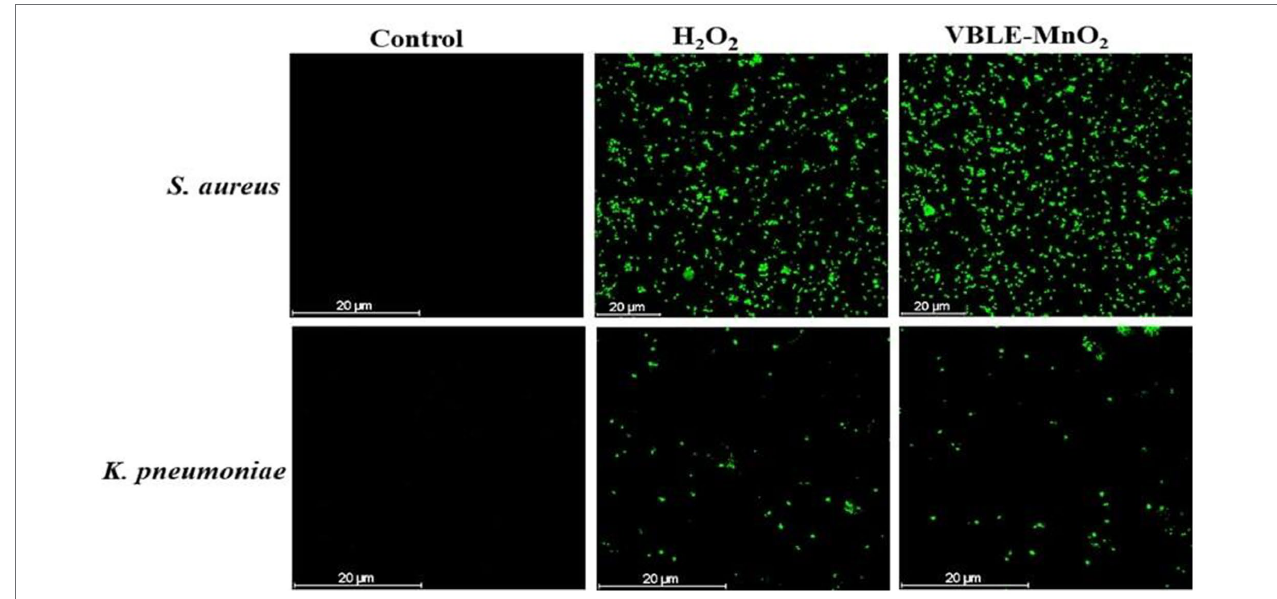
FIGURE 5 | CLSM images of ROS generation in untreated (control) and treated bacteria with hydrogen peroxide (H 2 O 2 ) and synthesized VBLE-MnO 2